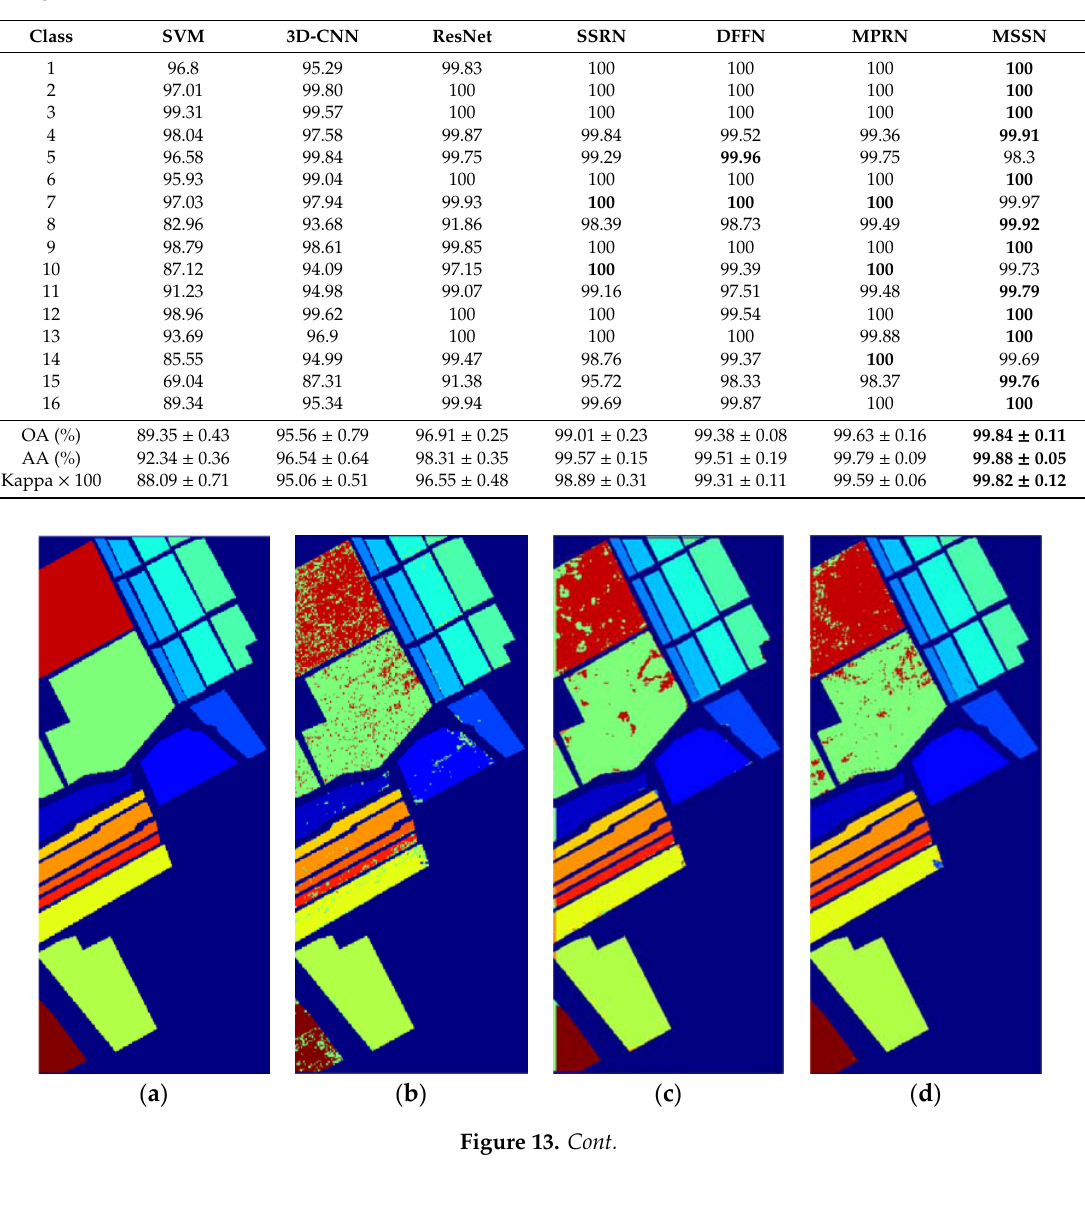
Table 6. Classification results obtained by di ff erent methods on the Salinas scene data set. Data are given as mean ± standard deviation.